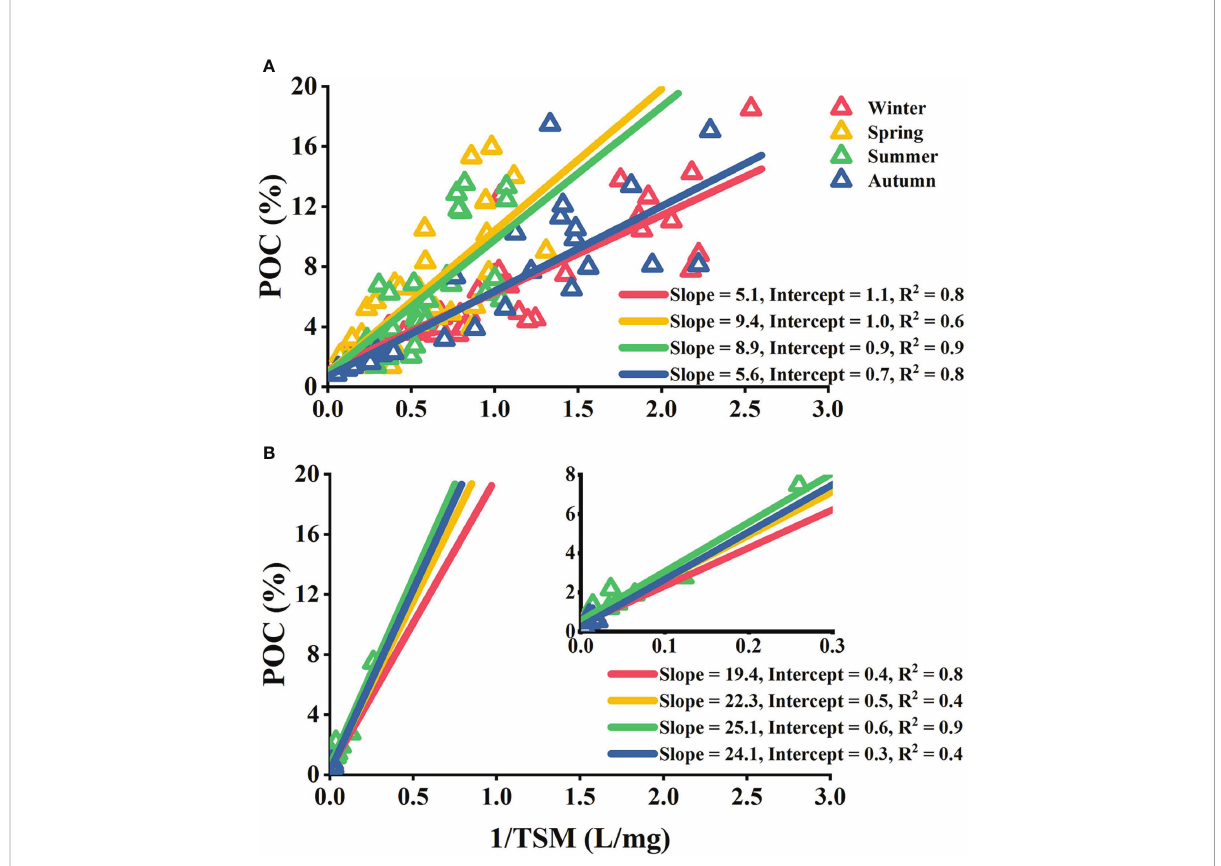
FIGURE 10 Fitting results of POC (%) vs. 1/TSM in the central basin (A) and the Subei coast region (B) . According to Eq. 7, the slope of the linear fi tting for POC (%) vs. 1/TSM is equal to S px ( f p − f s ) , and the intercept of that is equal to f s , where S p is the upper-layer phytoplankton concentration (mg L − 1 ), f p is the POC fraction of phytoplankton (%), and f s is the POC fraction of surface sediment (%). Seasons are distinguished by different colors. The inset view in panel (B) shows a related enlarged